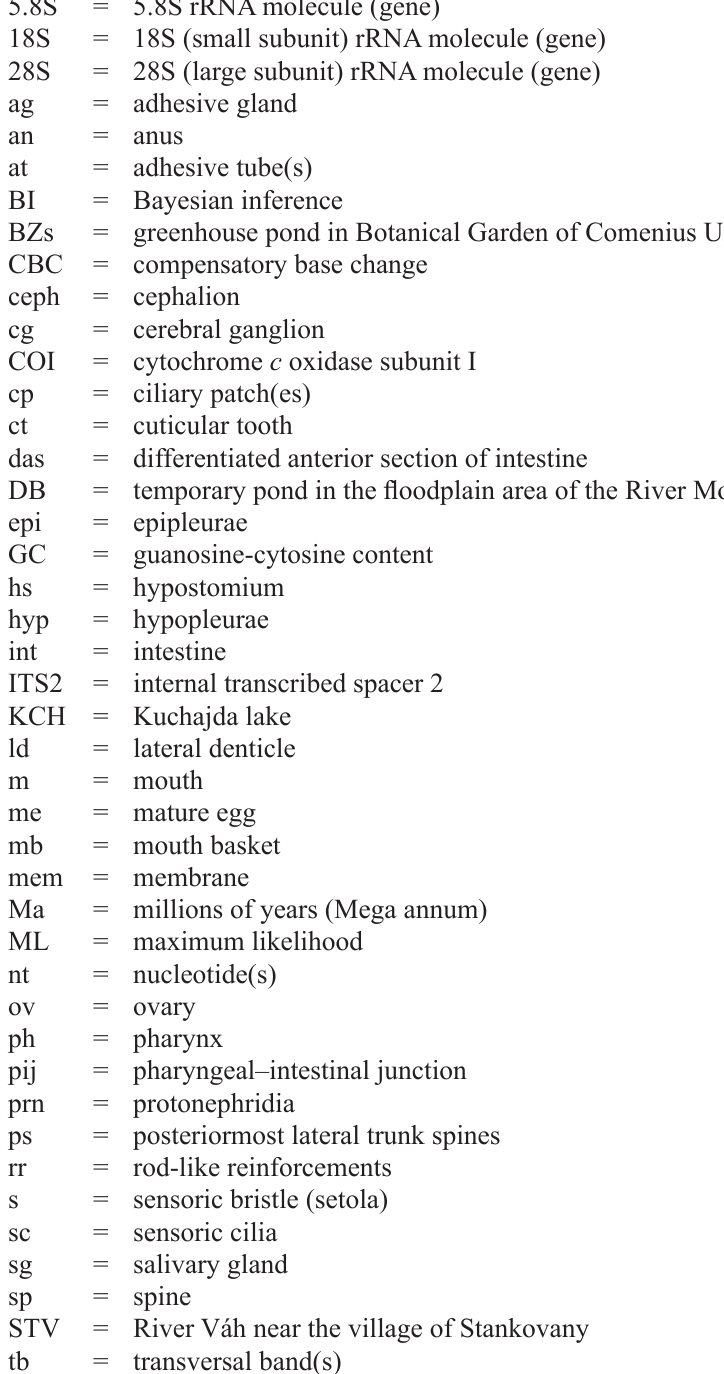
FigTree ver. 1.4.3